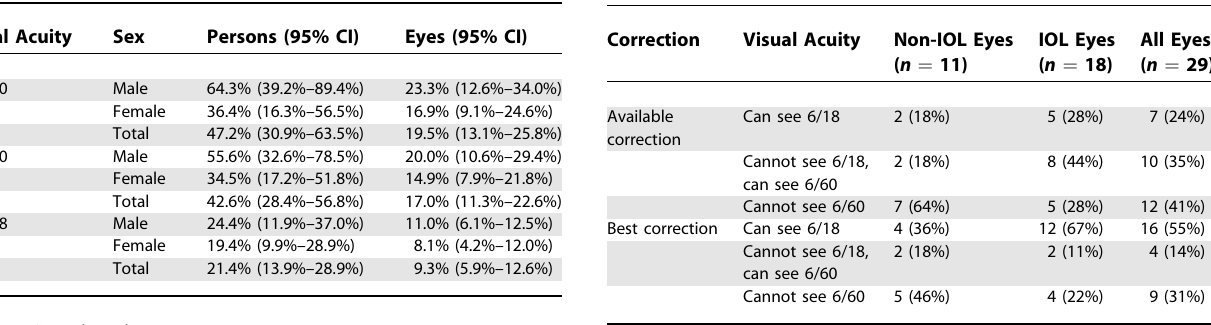
Table 5. Postoperative Visual Acuity in Eyes Following Cataract Surgery, by IOL